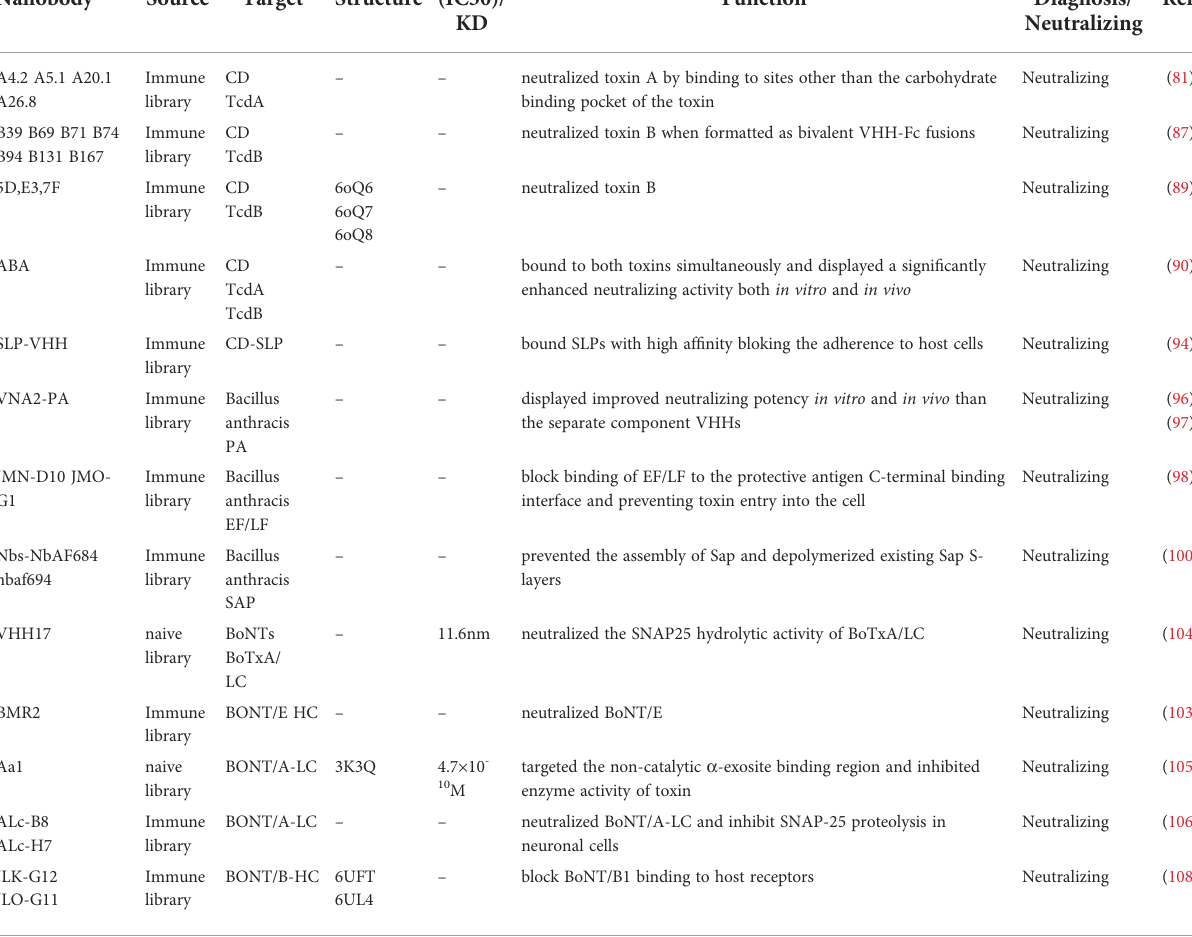
TABLE 3 SdAb reports to diagnosis and neutralization of infection by Gram-positive